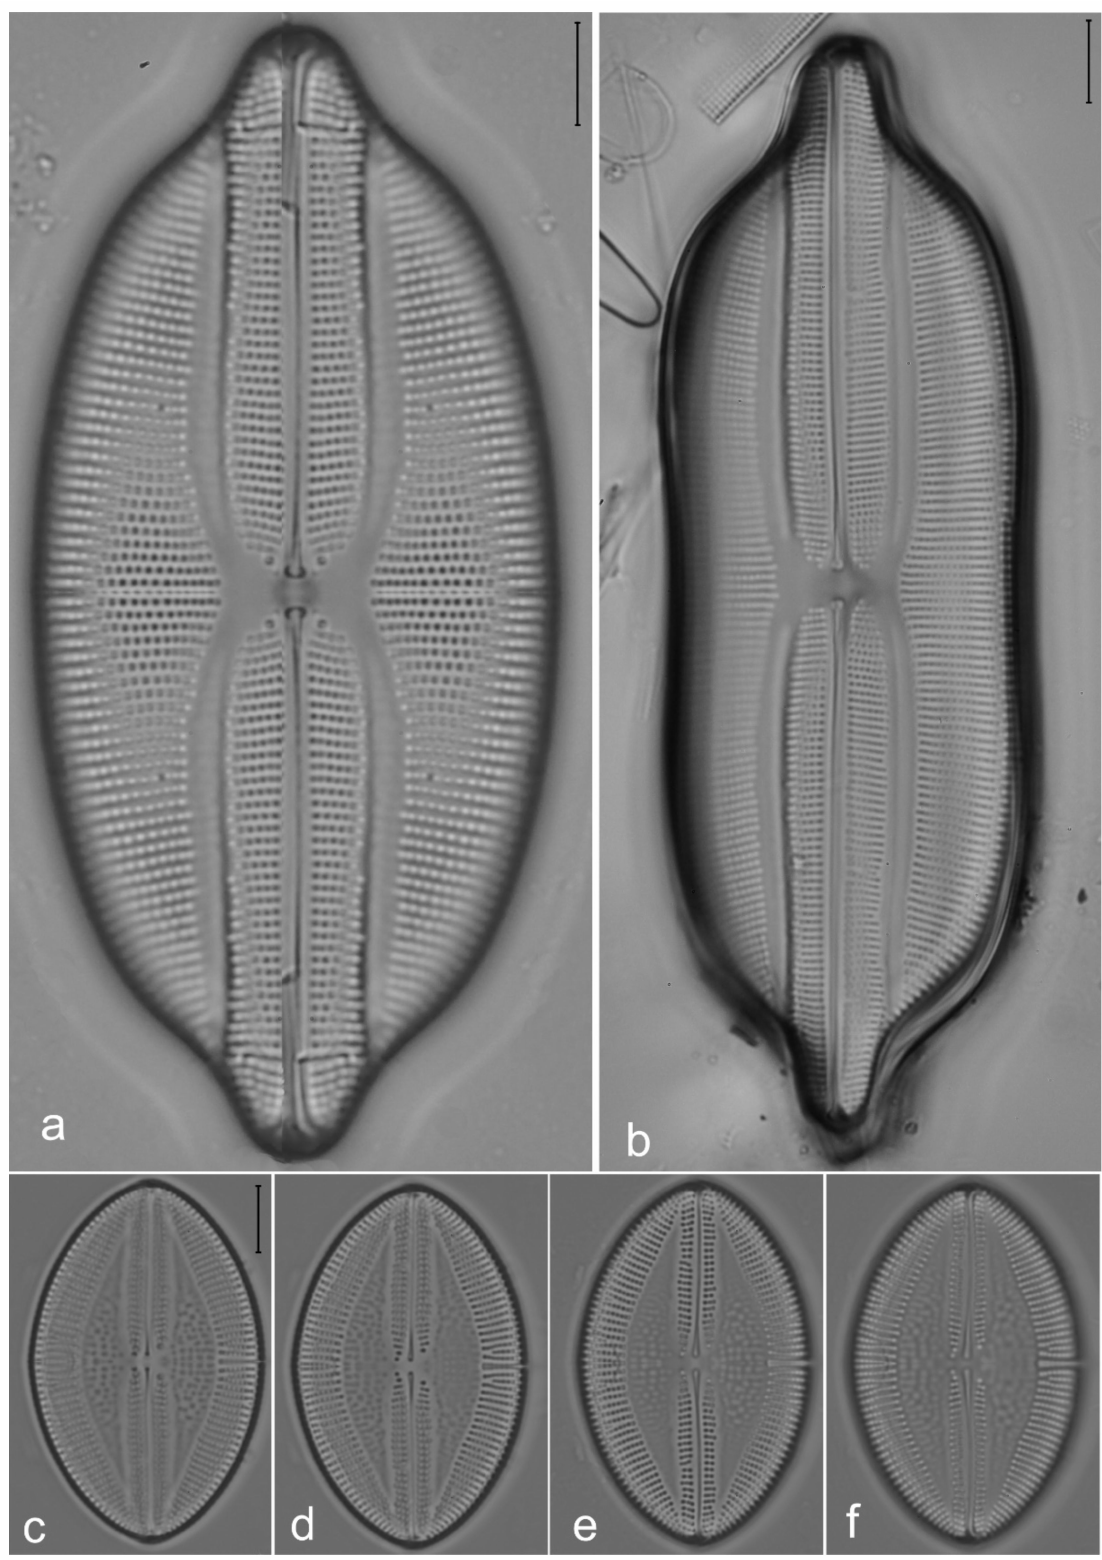
Figure 26. ( a ) Lyrella lyra var. lyra ; ( b ) L . lyra var. constricta ; ( c – f ) L . granulata in different focal planes. Scale bar = 10 µ